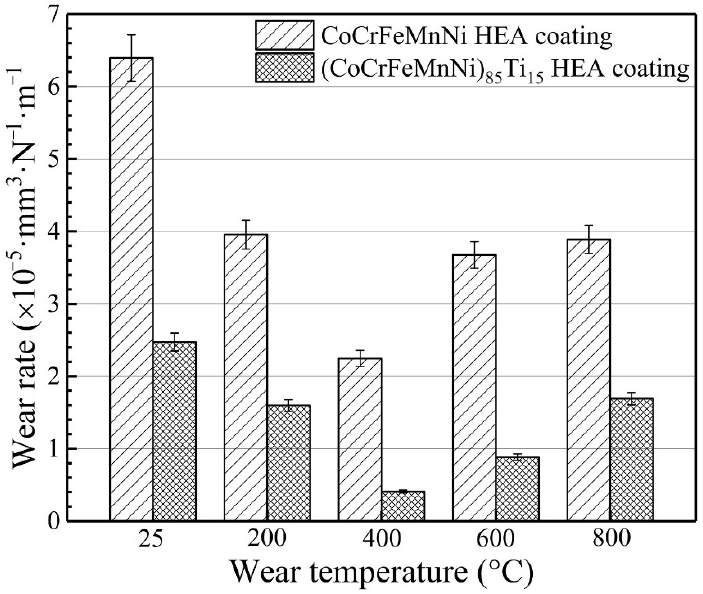
Figure 5. Two HEAs coating types of wear rate at different wear temperatures. Reprinted with permission from [30] Copyright 2020 Elsevier.